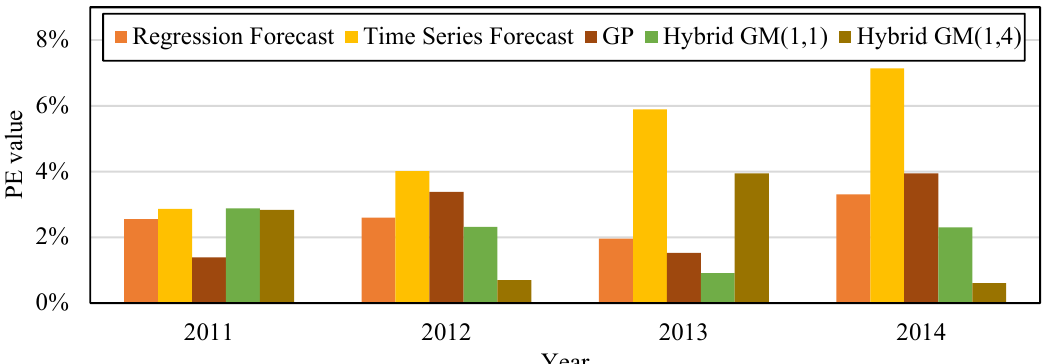
Figure 6. Comparison of forecast values of the five forecast models trained with the data from 2011–2013 and tested with the data in 2014.